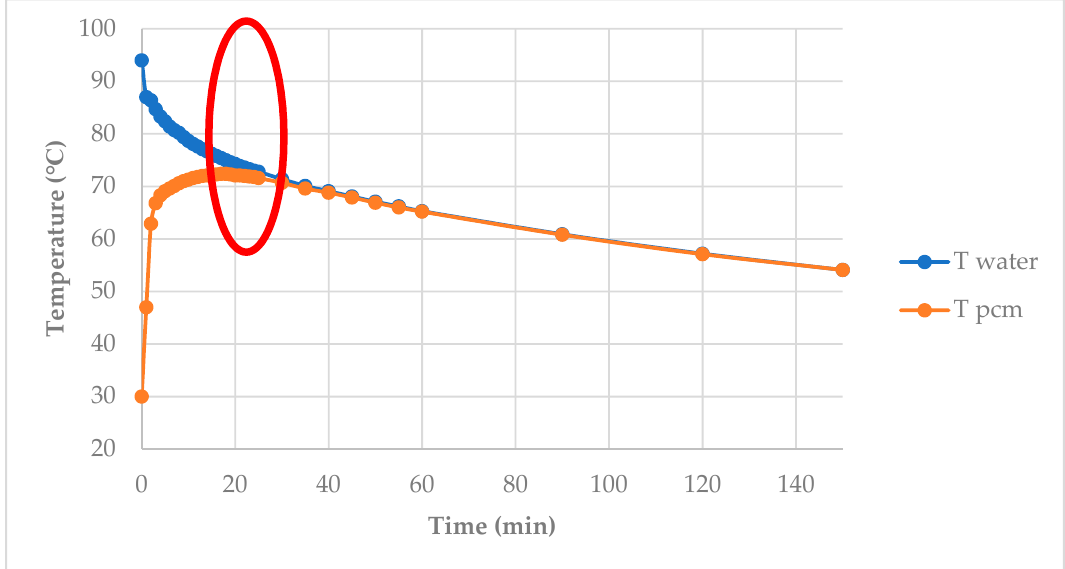
Figure 14. Temperature of hot water and PCMs vs. time: The red circle shows the region of significant heat transfer between water and the PCM.